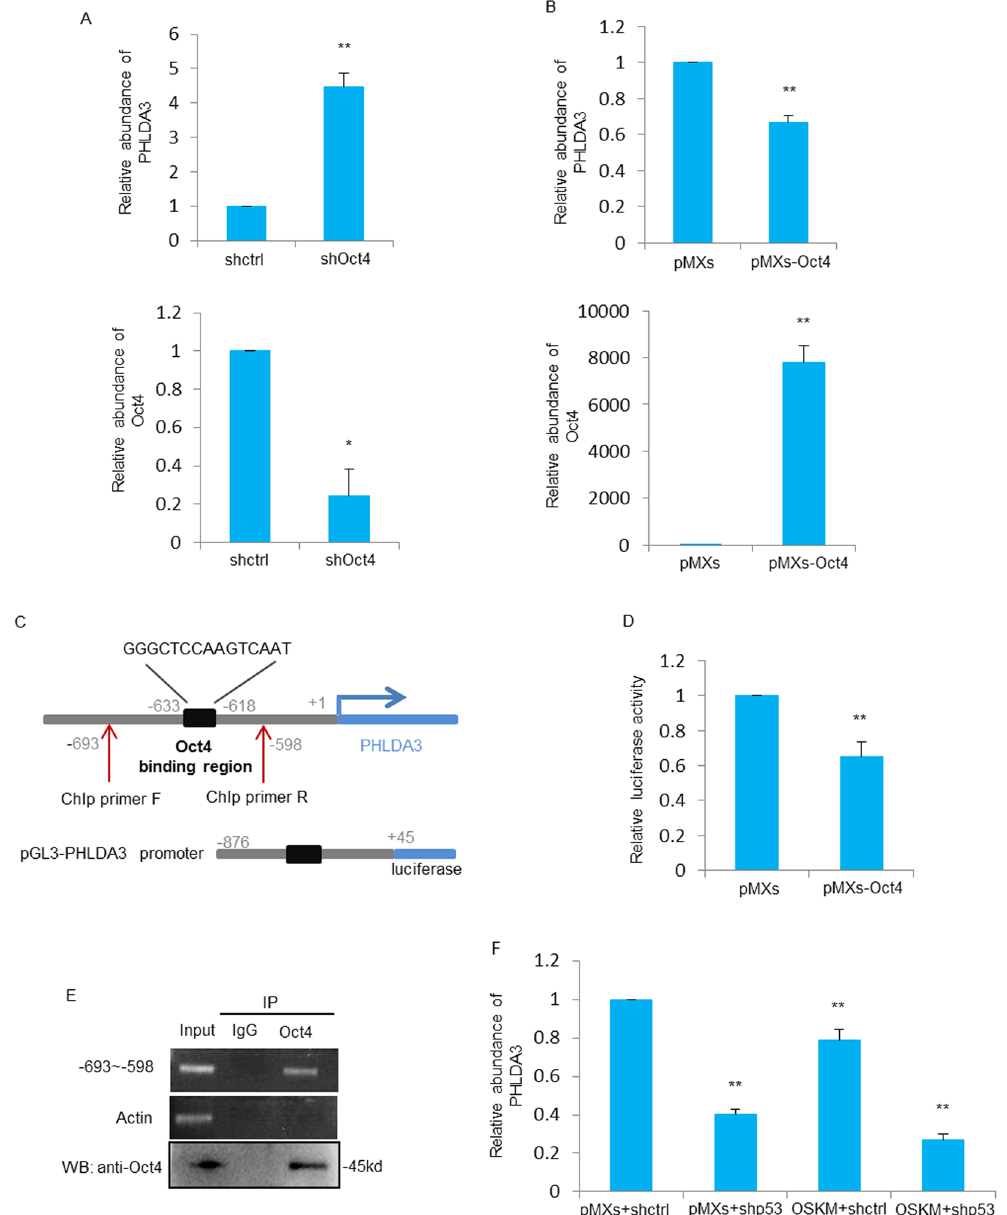
Figure 3. Oct4 transcriptionally inhibits PHLDA3 expression. ( A ) R1 cells were infected with control shRNA or Oct4 shRNA. Oct4 and PHLDA3 expression was detected by qRT-PCR analysis. ( B ) MEF cells were infected with retroviruses expressing control (pMXs) or pMXs- Oct4. Oct4 and PHLDA3 expression was detected by qRT-PCR analysis. ( C ) Schematic illustrations of the putative Oct4 binding region upstream of the PHLDA3 transcriptional start site and the pGL3-basic based PHLDA3 promoter reporter constructs and primers used for ChIp assay. ( D ) B16 cells co-transfected with the reporter constructs, renilla and Oct4 expression plasmids. Twenty-four hours later, cell lysates were subjected to luciferase analysis. ( E ) Genomic DNA from R1 cells was subjected to ChIP assay using Oct4 antibody, and the − 693~ − 598 region of PHLDA3 gene was detected by RT- PCR analysis. Actin was used as a negative control. ( F ) MEF cells expressing pMXs or OSKM were separately infected with either shRNA control or shRNA-p53 as indicated. Six days later, PHLDA3 expression was evaluated by qRT-PCR